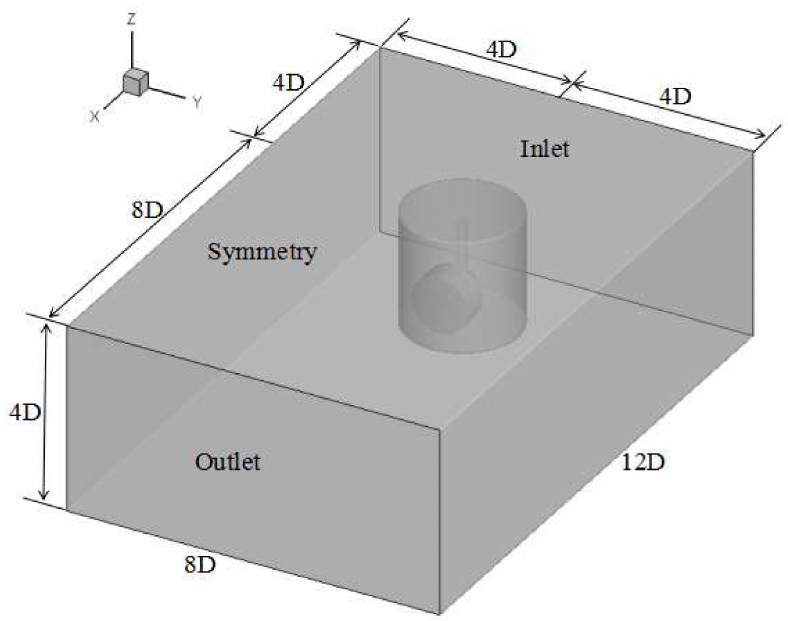
Figure 3. Computational domain.